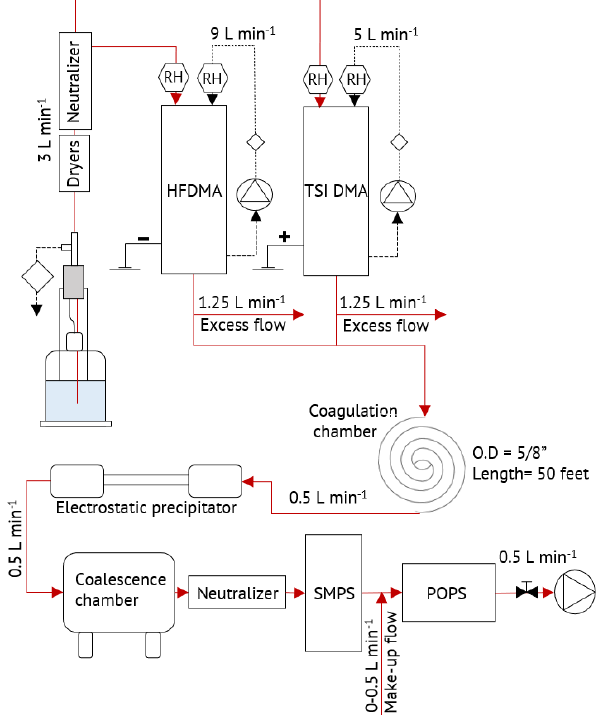
Figure 3. Schematic of the modified POPS instrument integrated into a dual tandem DMA setup. Symbols are as in Fig. 1.